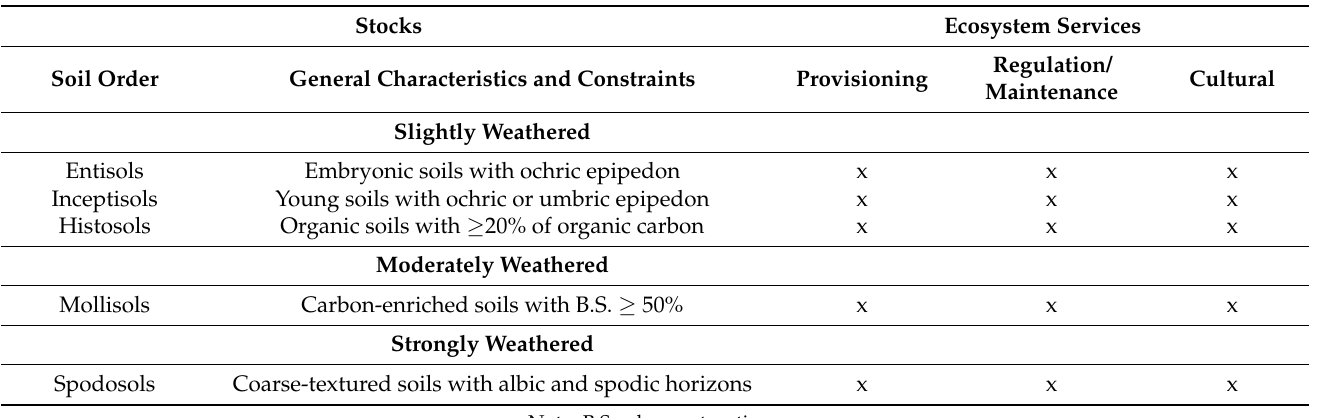
Table 1. Soil diversity (pedodiversity) is expressed as taxonomic diversity at the level of soil order and ecosystem service types in New Hampshire (U.S.A.) (adapted from Mikhailova et al., 2021 [3]). Stocks Ecosystem Services Regulation/ Soil Order General Characteristics and Constraints Provisioning Maintenance